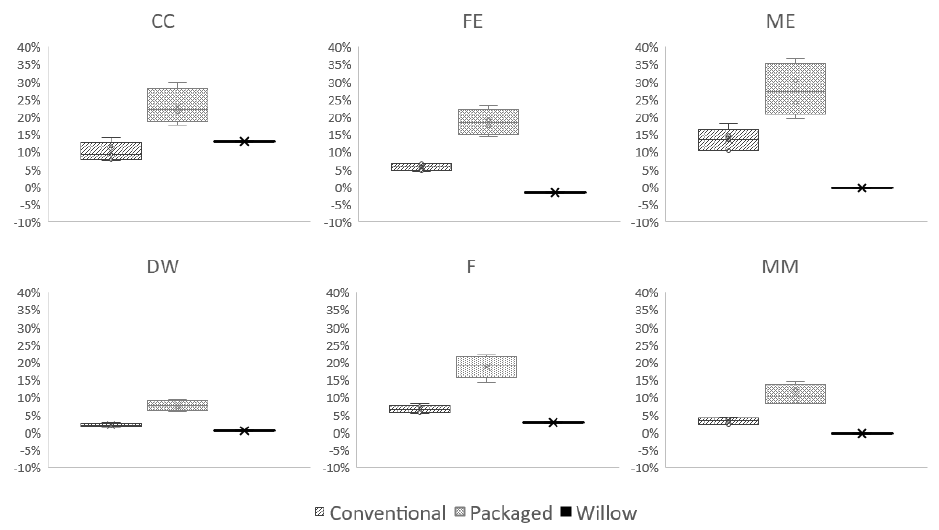
Figure 3. Net change on environmental impacts for each DWWTS for all six impact categories due to 50% more frequent desludging.